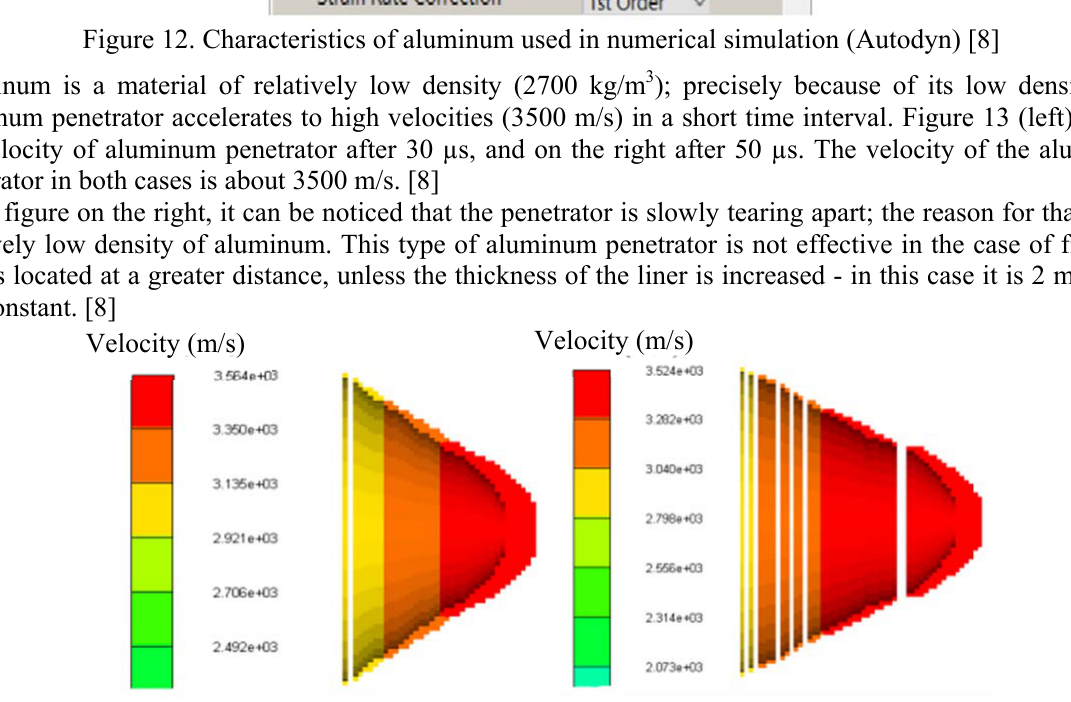
Figure 13. Velocity and shape of aluminum made penetrator (Autodyn); left-after 30 µs, right-after 50 µs [8]